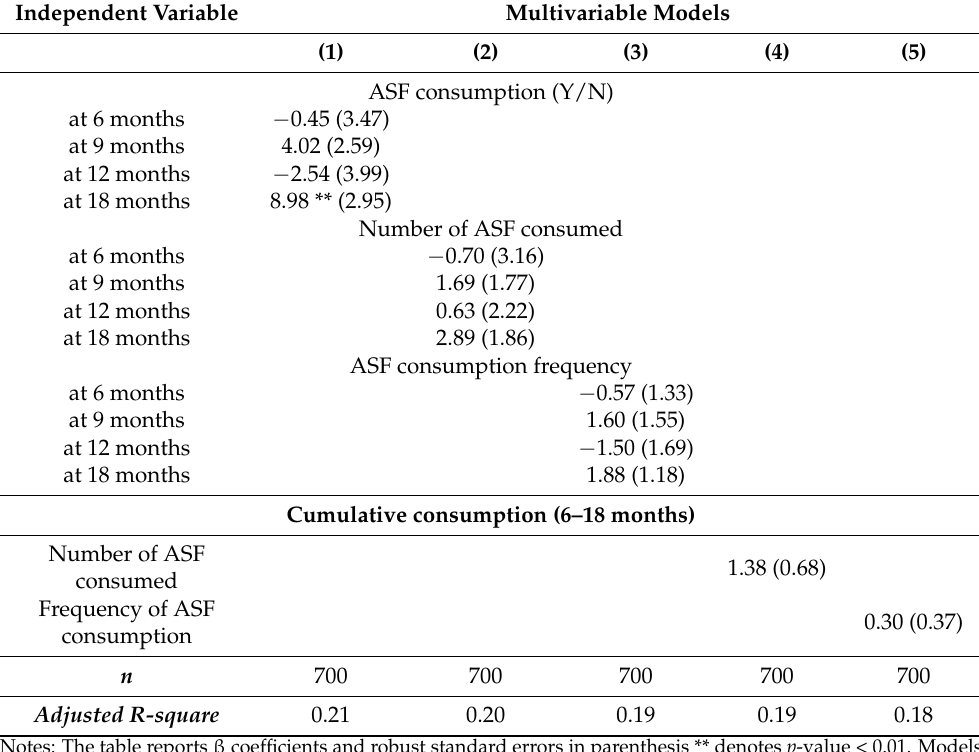
Table 3. Association of total ASQ scores and ASF consumption.